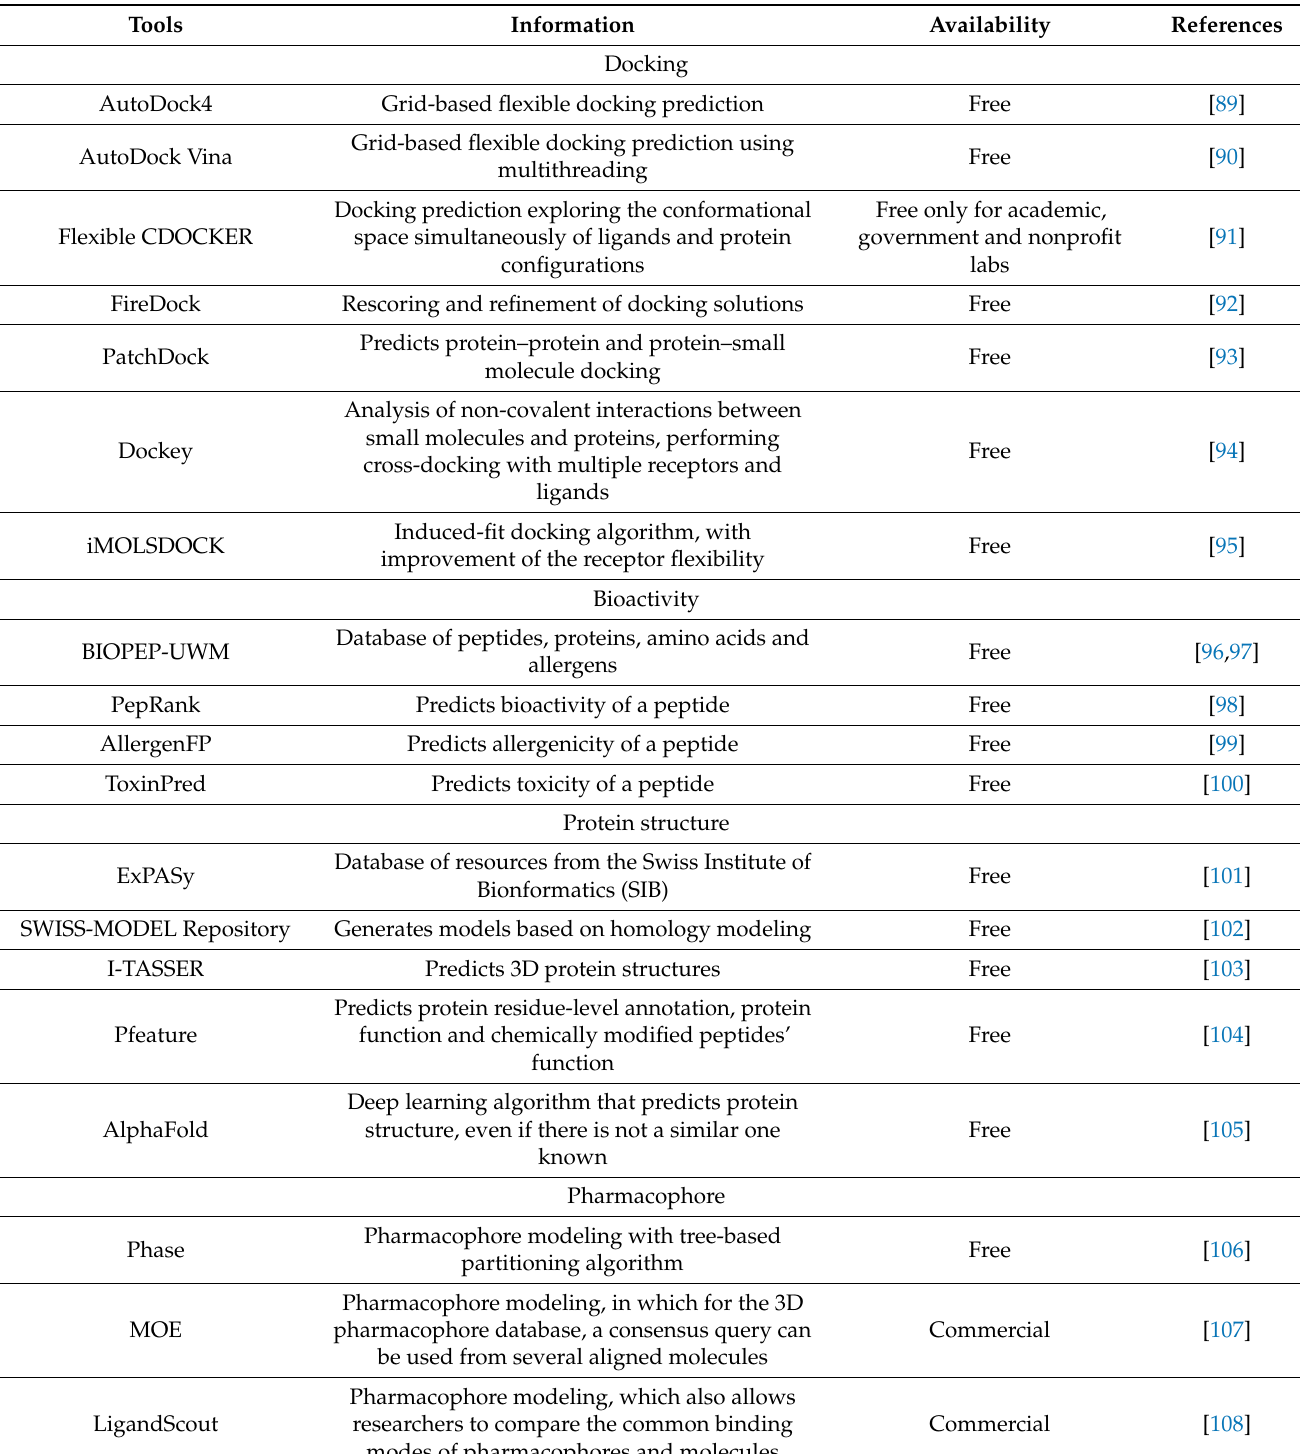
Table 1. Representative molecular in silico prediction programs, their main characteristics, free availability and corresponding